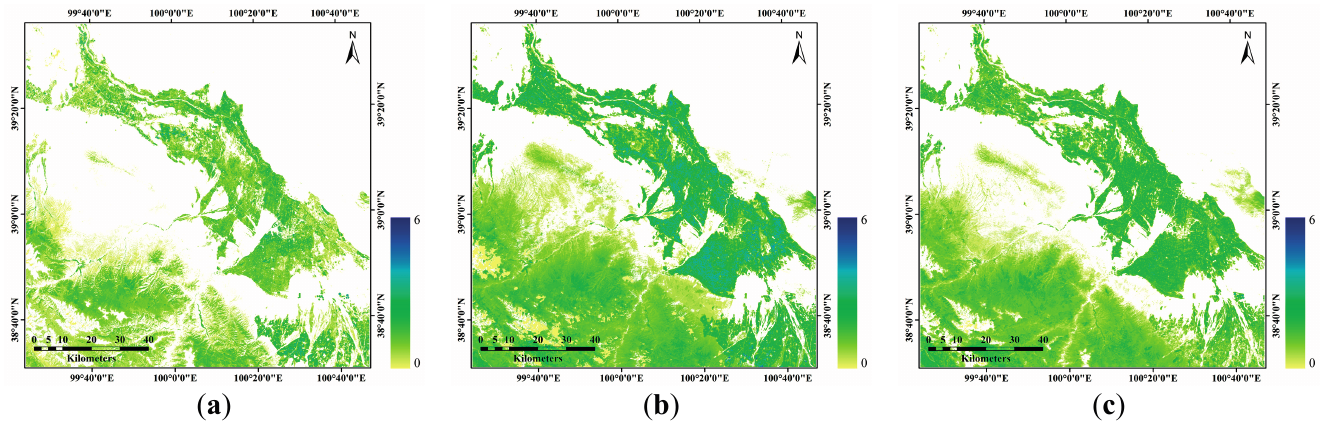
Figure 10. Maps of LAI inversion over three 10-day observation periods from HJ1/CCD and Landsat8/OLI. ( a ) 1 June 2013; ( b ) 11 July 2013; and ( c ) 20 August